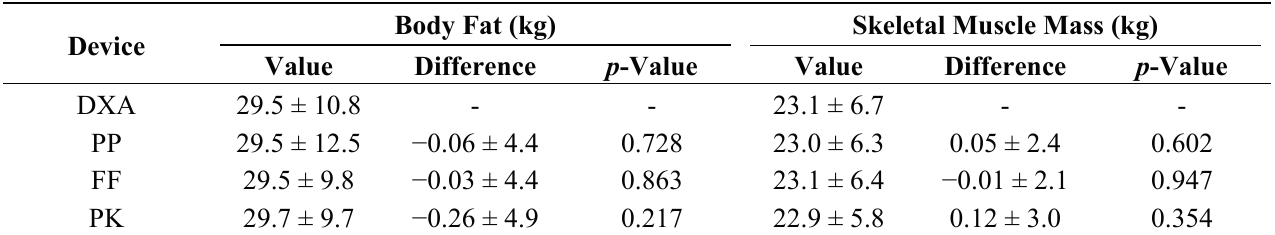
Table 6. Estimated values and differences relative to target values (paired t